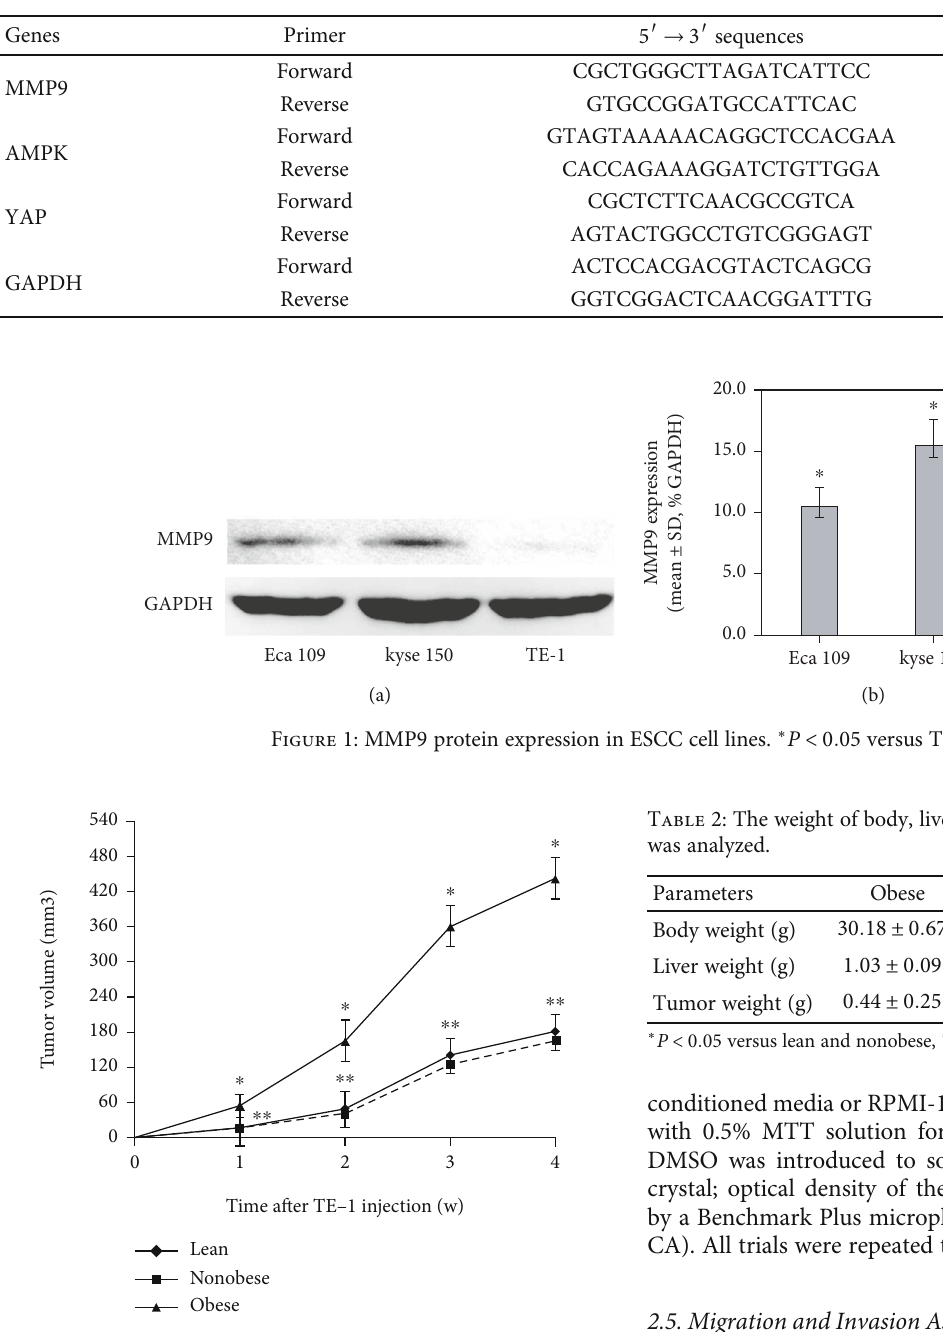
Table 1: Sequences of the primers in the RT-PCR assay.